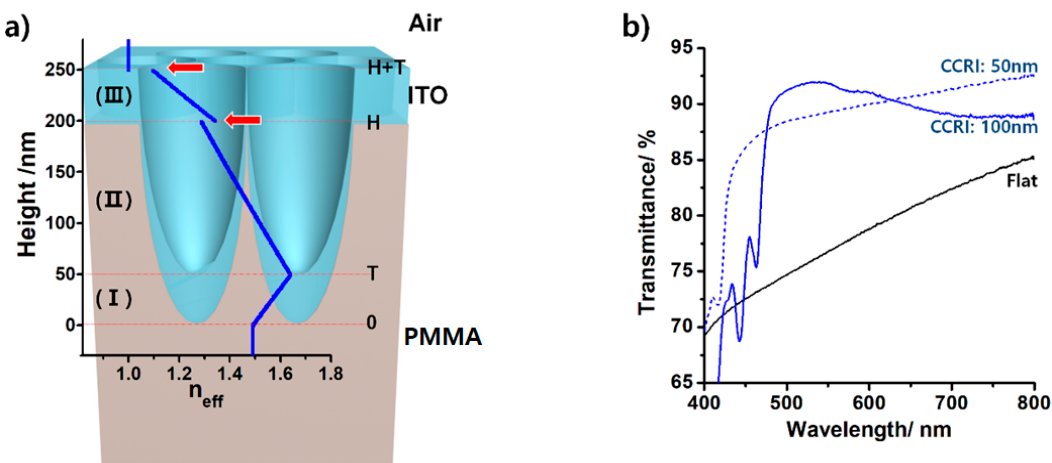
Figure 3. ( a ) Effective refractive index profile ( n eff , blue line) of CCRI-ITO film along the film thickness direction. The refractive index discontinuities are indicated by the red arrows. ( b ) Optical transmittance over the visible wavelength range for CCRI-ITO films with the same (CCRI1, blue dotted line) and twofold higher (CCRI2, blue solid line) deposition time as the 50 nm thick flat ITO film (transmittance indicated by black line).